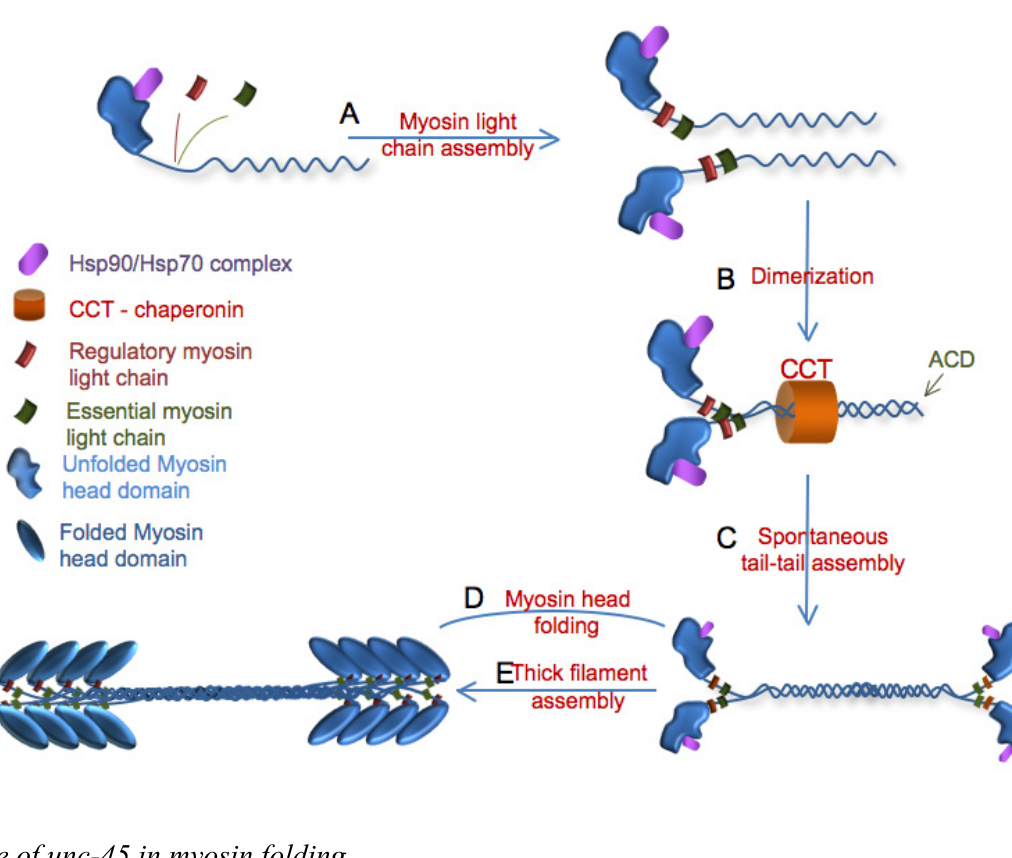
Figure 2. Myosin maturation. A) Nascent myosin molecules associate with the Hsp70/Hsp90 complex (purple). Myosin light chain assembly (green and red) and folding of the tail region occurs rapidly. B) Dimerization of the myosin tails may require the chaperonin CCT (orange). C) The assembly-competence domain (ACD) at the extreme C-terminus promotes tail-tail dimer formation. D) Myosin head folding is the rate limiting step and can occur at any point in this cascade. E) Assembly of myosin into thick filaments likely requires many different factors but does not require properly folded myosin heads. Note: the exact position of Hsp90 binding within the head domain is